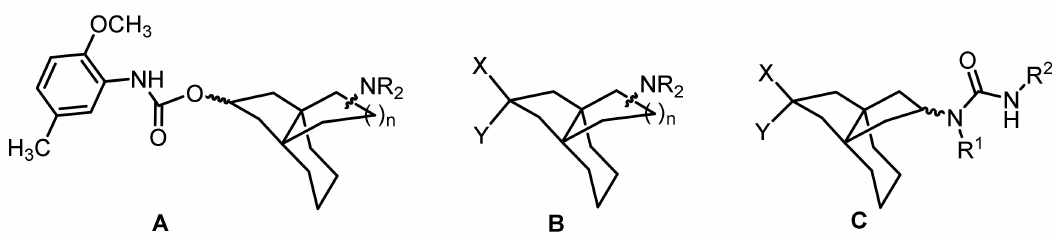
Figure 3. Designed σ receptor ligands of type A–C . In types A and B , the basic amino moiety is either attached at the cyclopentane ring ( m = 1) or incorporated into a ring expanded piperdiene ring ( n = 2).